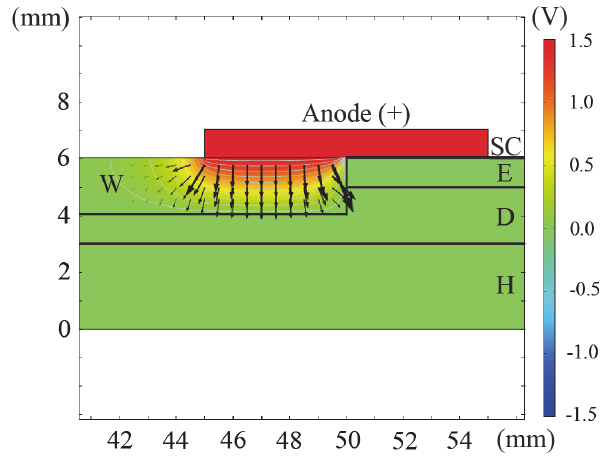
Fig.7: The electric field in the wound area with a wound dressing POSiFECT ® applied. Of interest is of course the influence of the electrode closest to the wound edge where we see major effects. We therefore only show the situation for the anode ring. Field strengths are much larger than the endogenous electric field also for this